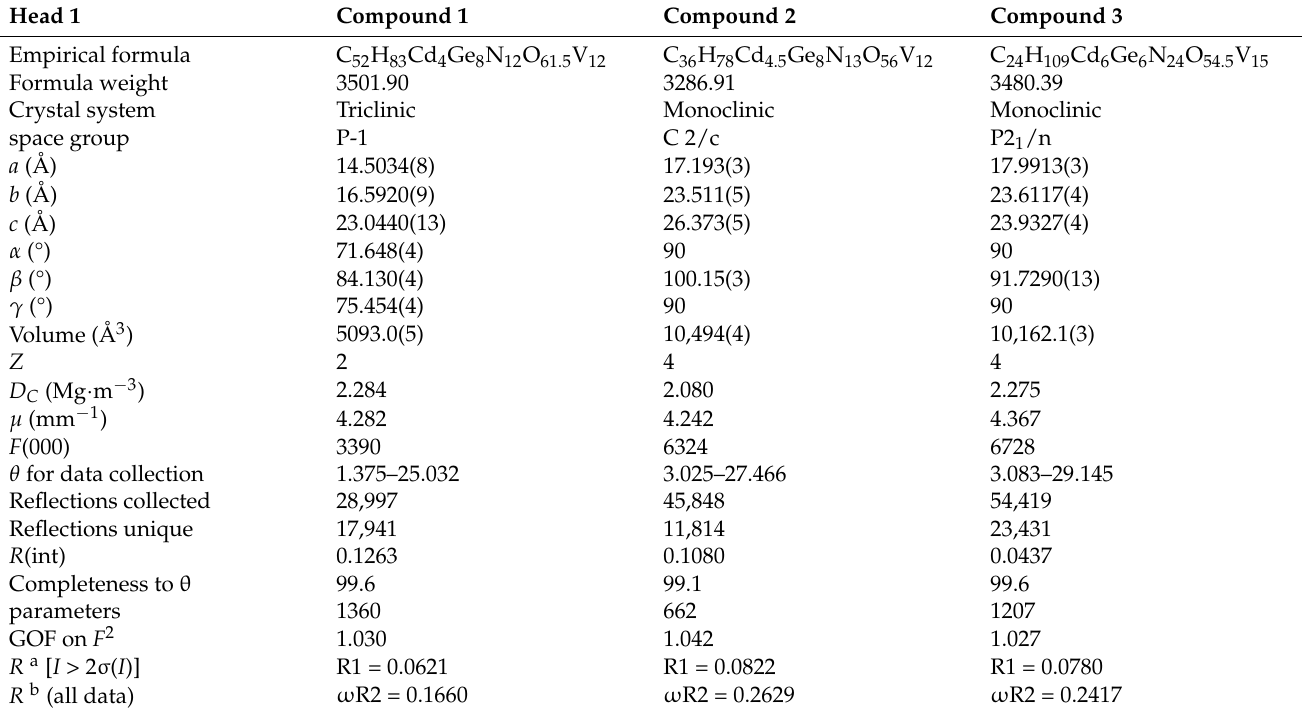
Table 1. Crystal data and structure refinements for compounds 1 – 3